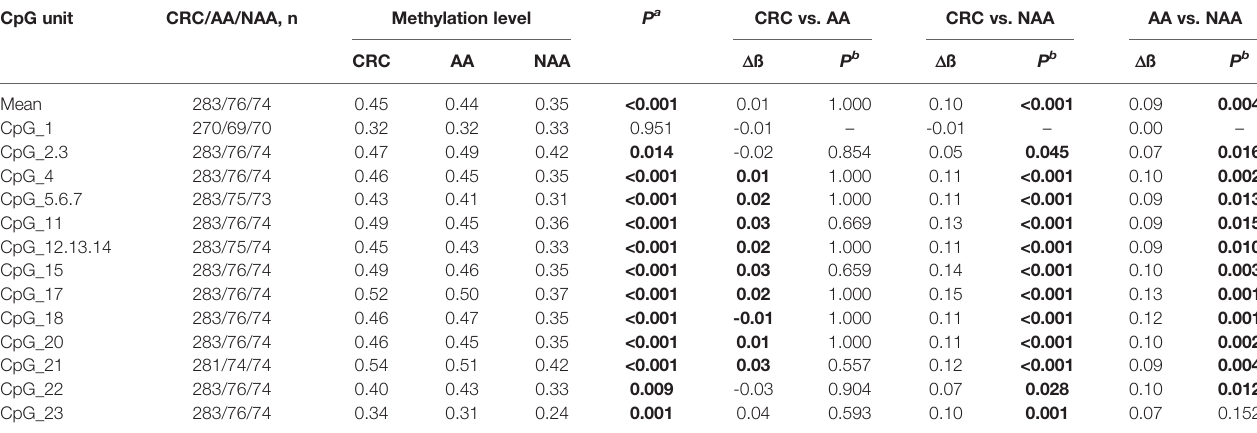
TABLE 2 | DLX6-AS1 methylation differences between colorectal cancer, advanced adenoma and nonadvanced adenoma